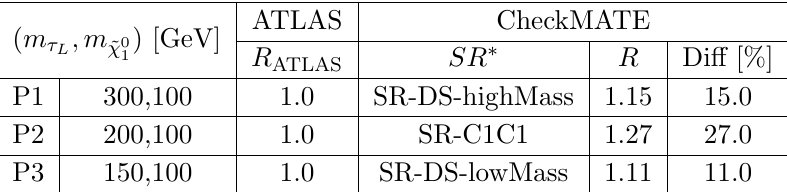
Table 7 . Similar to table 4, but for the ~ (cid:28) L ~ (cid:28) L production process with the corresponding ATLAS results plotted in (cid:12)gure 8b of